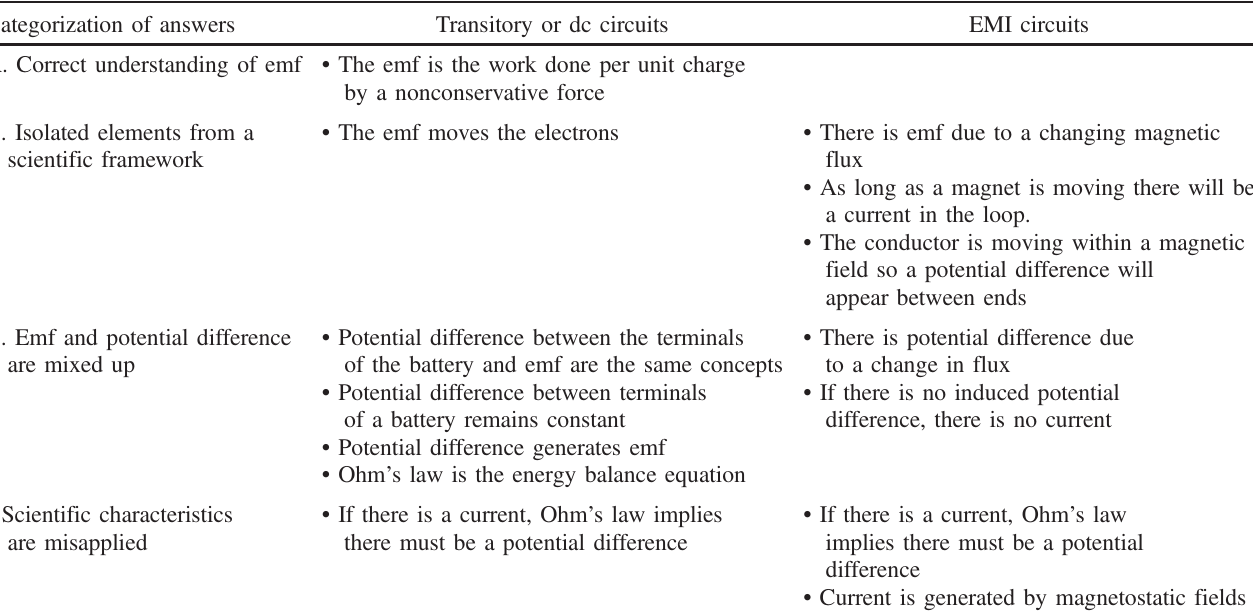
TABLE I. Summary of arguments used by introductory physics students to explain open ended questions dealing with emf [14,15]. Categorization of answers